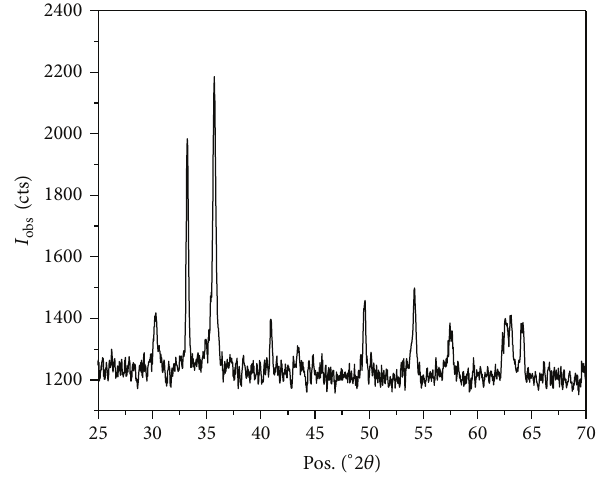
Figure 1: XRD pattern of the 𝛼 -Fe 2 O 3 nanopowder.